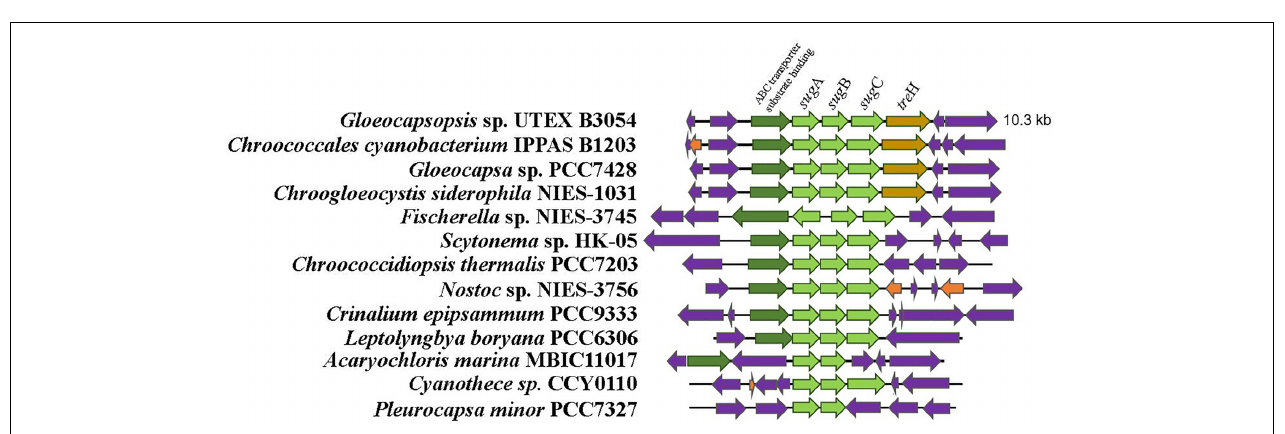
FIGURE 2 | Phylogeny of cyanobacterial trehalase. Maximum-likelihood tree was generated with IQTree Software based on the evolutionary substitution model LG + I + G4. Trehalase proteins from the Chroococcaceae family (gray box) show an early divergence in comparison with Nostocales and other cyanobacteria. Number at the nodes indicate bootstrap values from phylogenetic analysis.